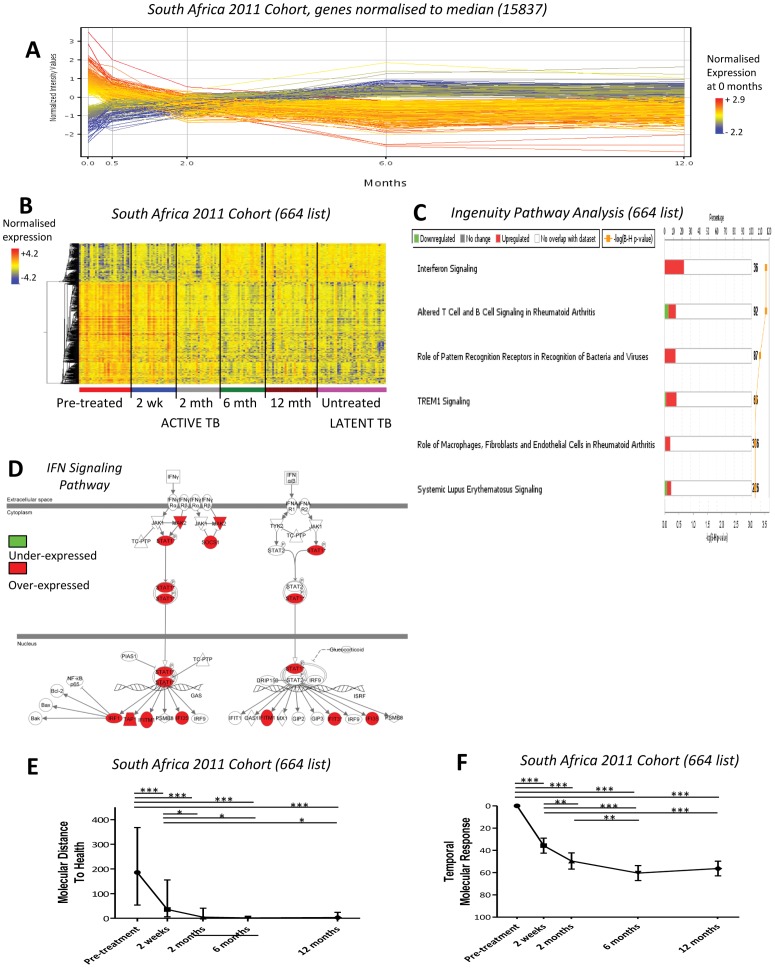
A blood transcriptional response is detectable after only 2 weeks of treatment.
(A) Profile plot of all detectable transcripts (15837) obtained without any filtering, in the treated active TB patients in the South Africa 2011 cohort. It can be seen that gene expression changes after just 2 weeks of treatment. (B) 664 differentially expressed transcripts between untreated active and latent TB patients in the untreated South Africa 2011 cohort, were obtained by twofold change from the median and stringent statistical filtering (Mann Whitney, Bonferroni p<0.01). The heatmap shows the dynamic change of gene expression in response to treatment in the treated South Africa 2011 cohort normalised to the median of all transcripts. (C) Ingenuity Pathway Analysis (IPA) of the 664 transcripts shows the top significant pathways. (D) Interferon signaling pathway from the 664 list in IPA. (E) Weighted molecular distance to health (MDTH) of the treated South Africa 2011 cohort shows the signature significantly diminishes over time (linear mixed models, bars represent median & IQR, *** = p<0.001, ** = p<0.01, * = p<0.05). (F) Temporal molecular response further shows significant and early changes in response to anti-TB treatment (linear mixed models, bars represent mean & 95% confidence intervals).